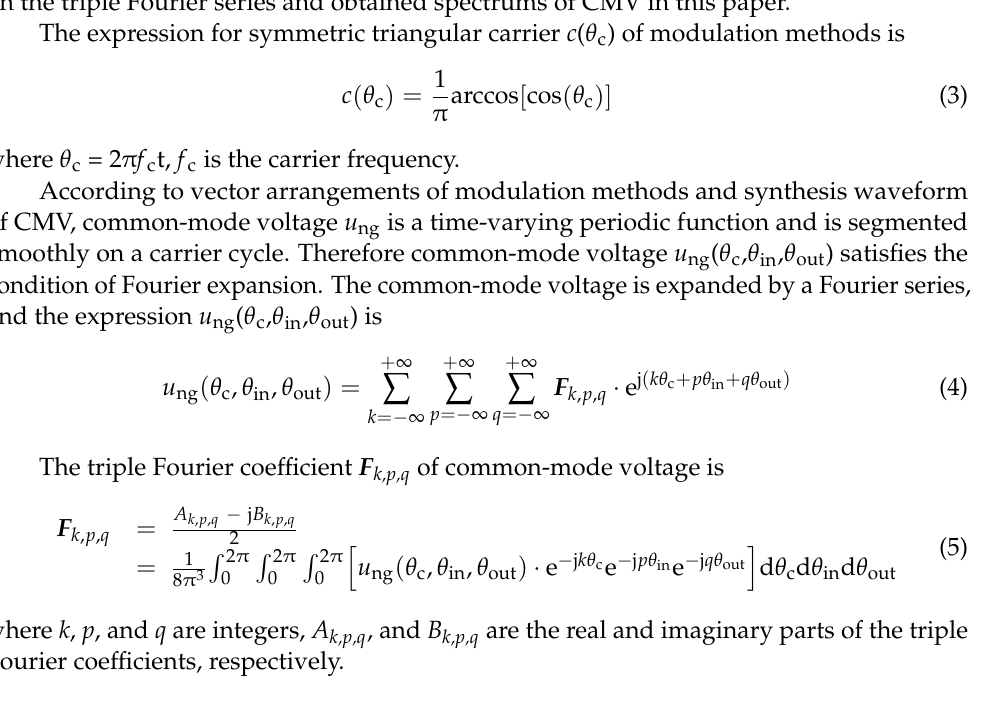
Figure 9. Modulation principle and vector distribution of method 5.